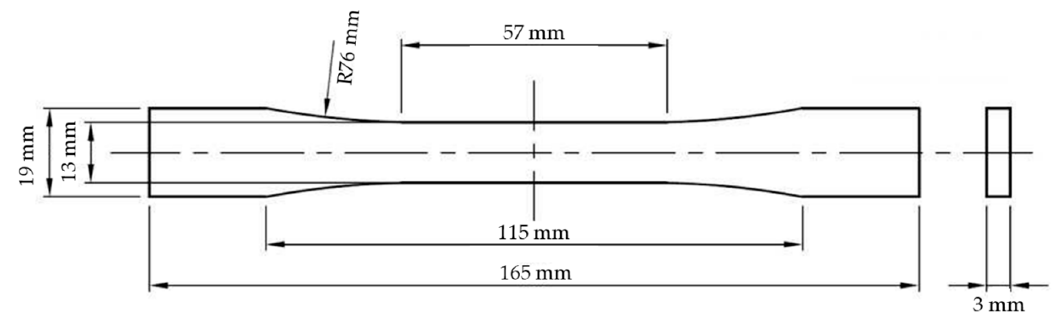
Figure 1. Tensile test specimen dimension according to American Society for Testing and Materials (ASTM) D638 Type I [34] .